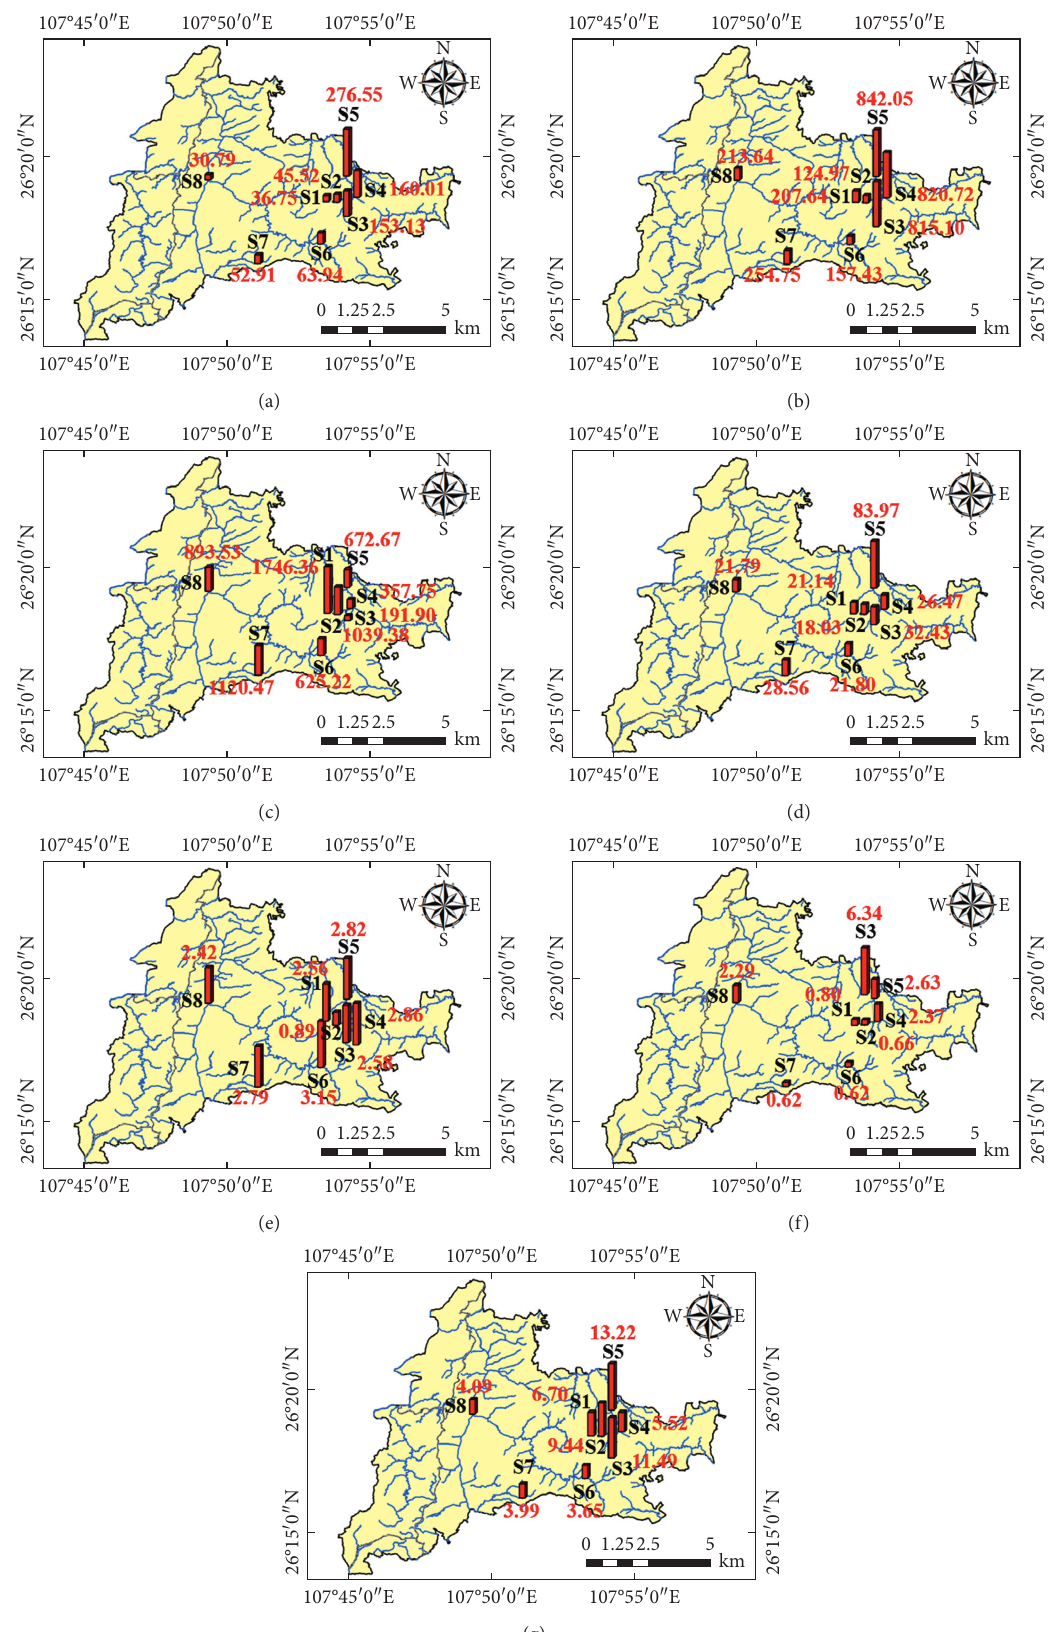
Figure 2: Spatial distribution maps of average contents of HMs in the sediments in the study area. (a) Pb (mg kg − 1 ), (b) Zn (mg kg − 1 ), (c) Mn (mg kg − 1 ), (d) Cu (mg kg − 1 ), (e) Cd (mg kg − 1 ), (f) Hg (mg kg − 1 ), (g) As (mg kg − 1